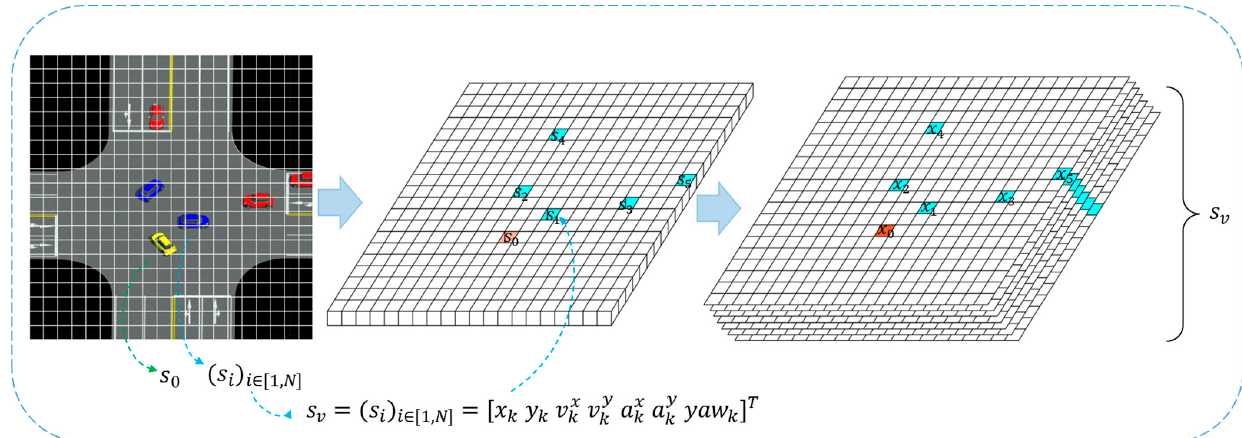
Figure 9. Vehicle status information pre-processing process.